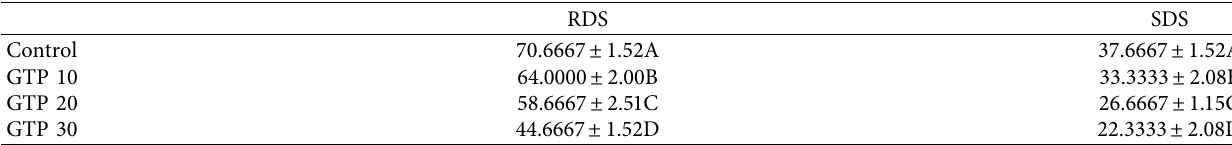
Table 7: The glycemic potential of various sponge cake